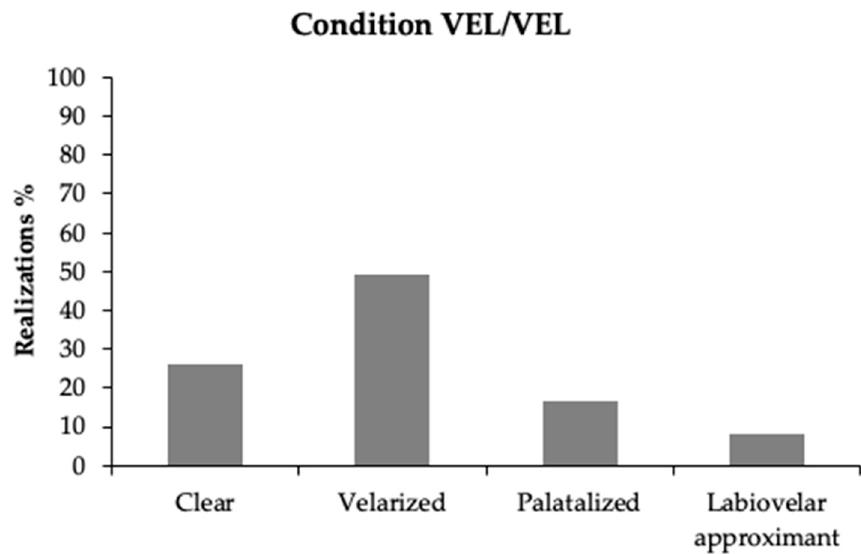
Figure 2. The production of the L3 lateral in condition VEL/VEL.